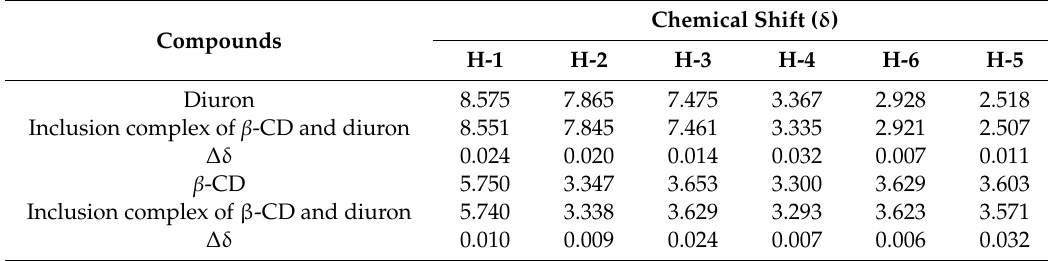
Table 1. Chemical shift of inclusion complexes relative to diuron and cyclodextrin.